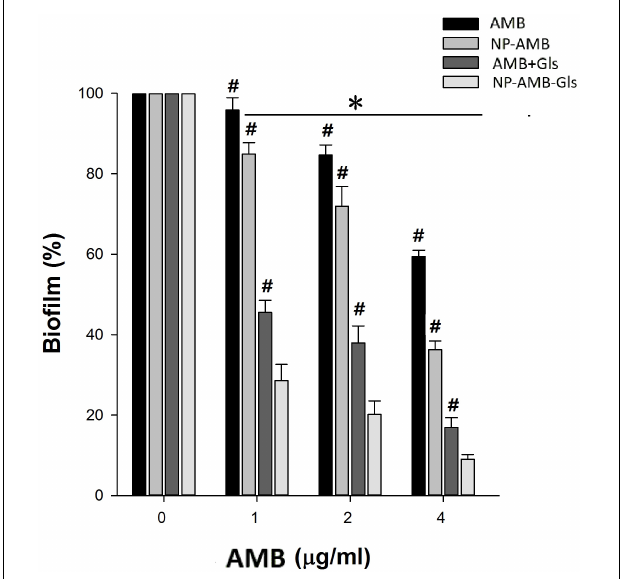
FIGURE 4 | Inhibition efficacy on the biofilm in a 96-well microplate. Candida albicans DAY 185 cells were co-incubated with free AMB, AMB+Gls, CSNPs-AMB, and CSNPs-AMB-Gls with different drug concentrations (0, 0.25, 0.5, and 1 µ g/ml) for 24 h. The results represent the means and standard deviations (SDs) (error bars), n = 3. Statistical significance was determined by the t -test analysis. * p < 0.05 for comparison between the untreated and treated groups.